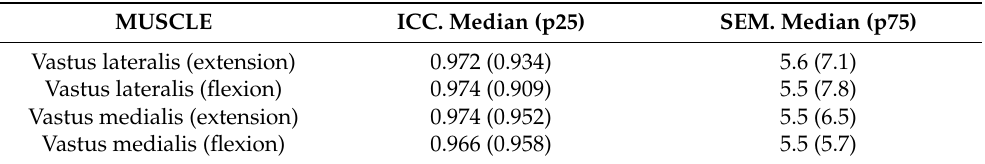
Table 5. Agreement between the muscle force estimates by SGM and as estimated using Force–EMG calibration. The forces estimated by the SGM model for the L1 load condition are compared with the forces calculated from the Force–EMG calibration curves of the L0 and L2 conditions, using the EMG signal of the L1 tests. n =